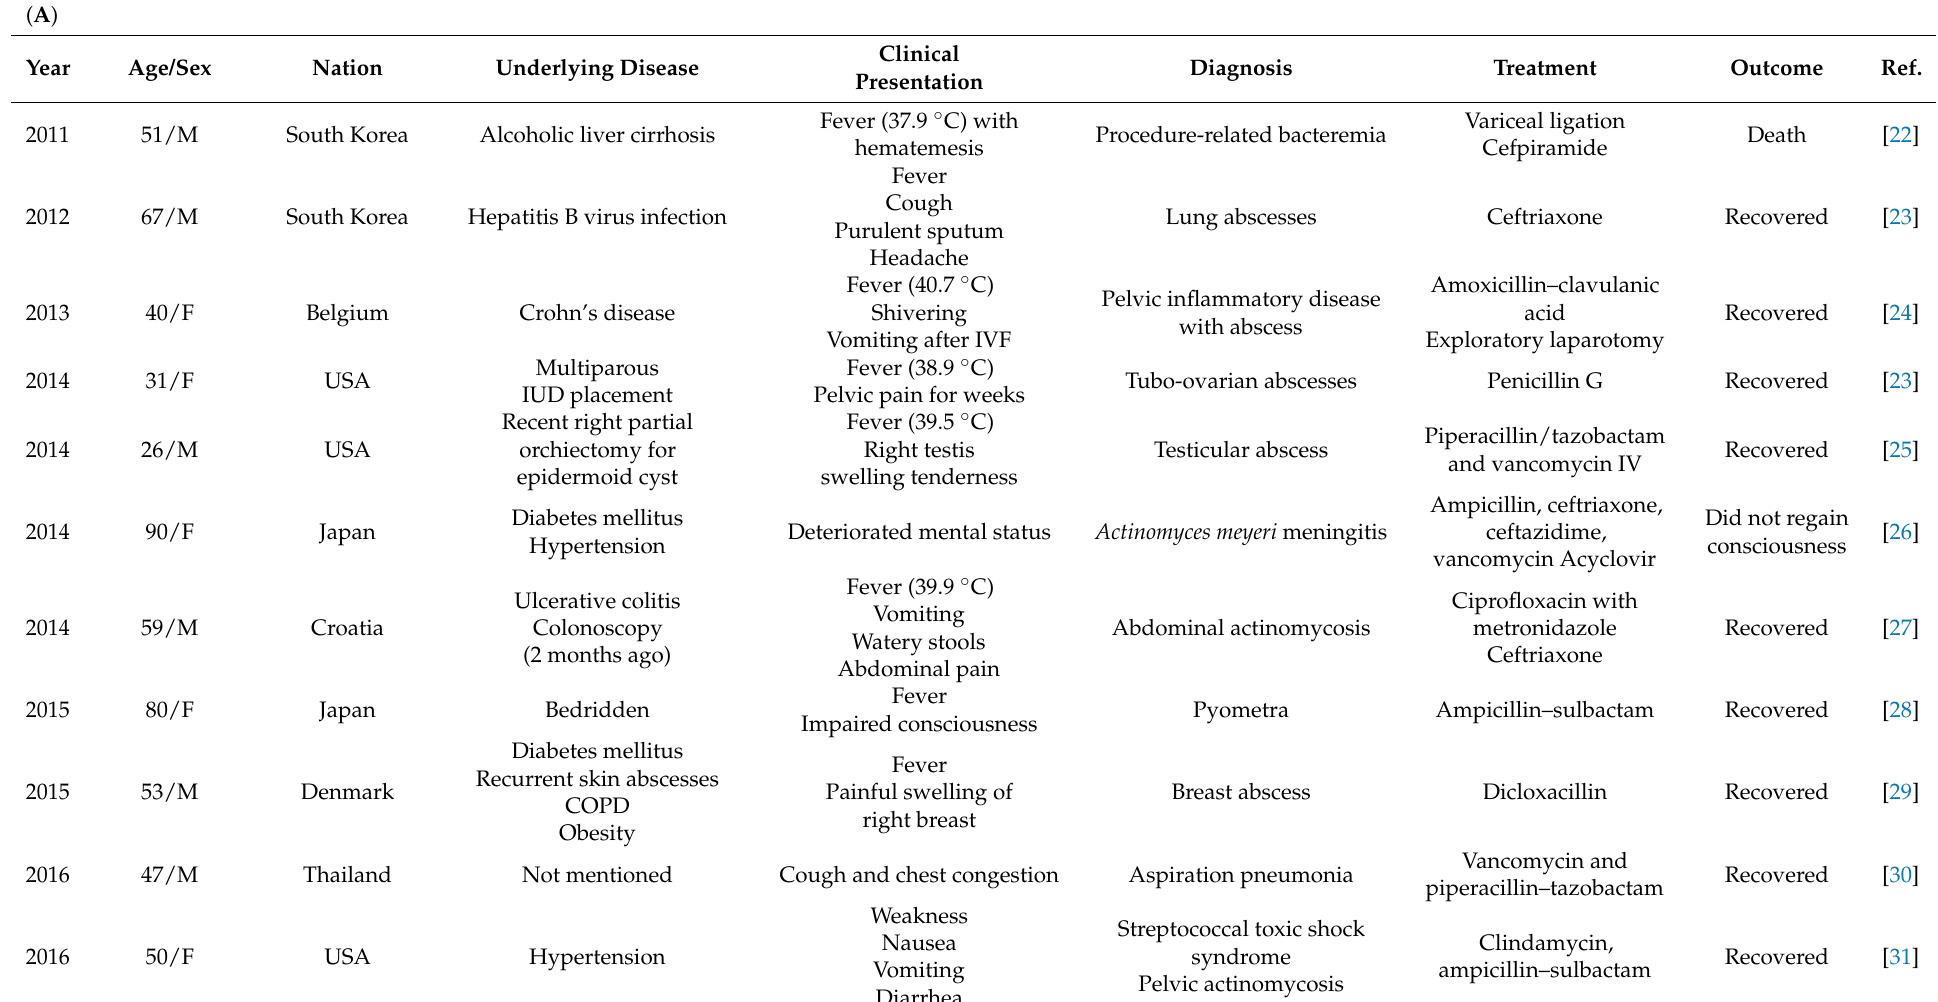
Table 1. Characteristics and identification profile of Actinomyces bacteremia cases reported from 2010 to